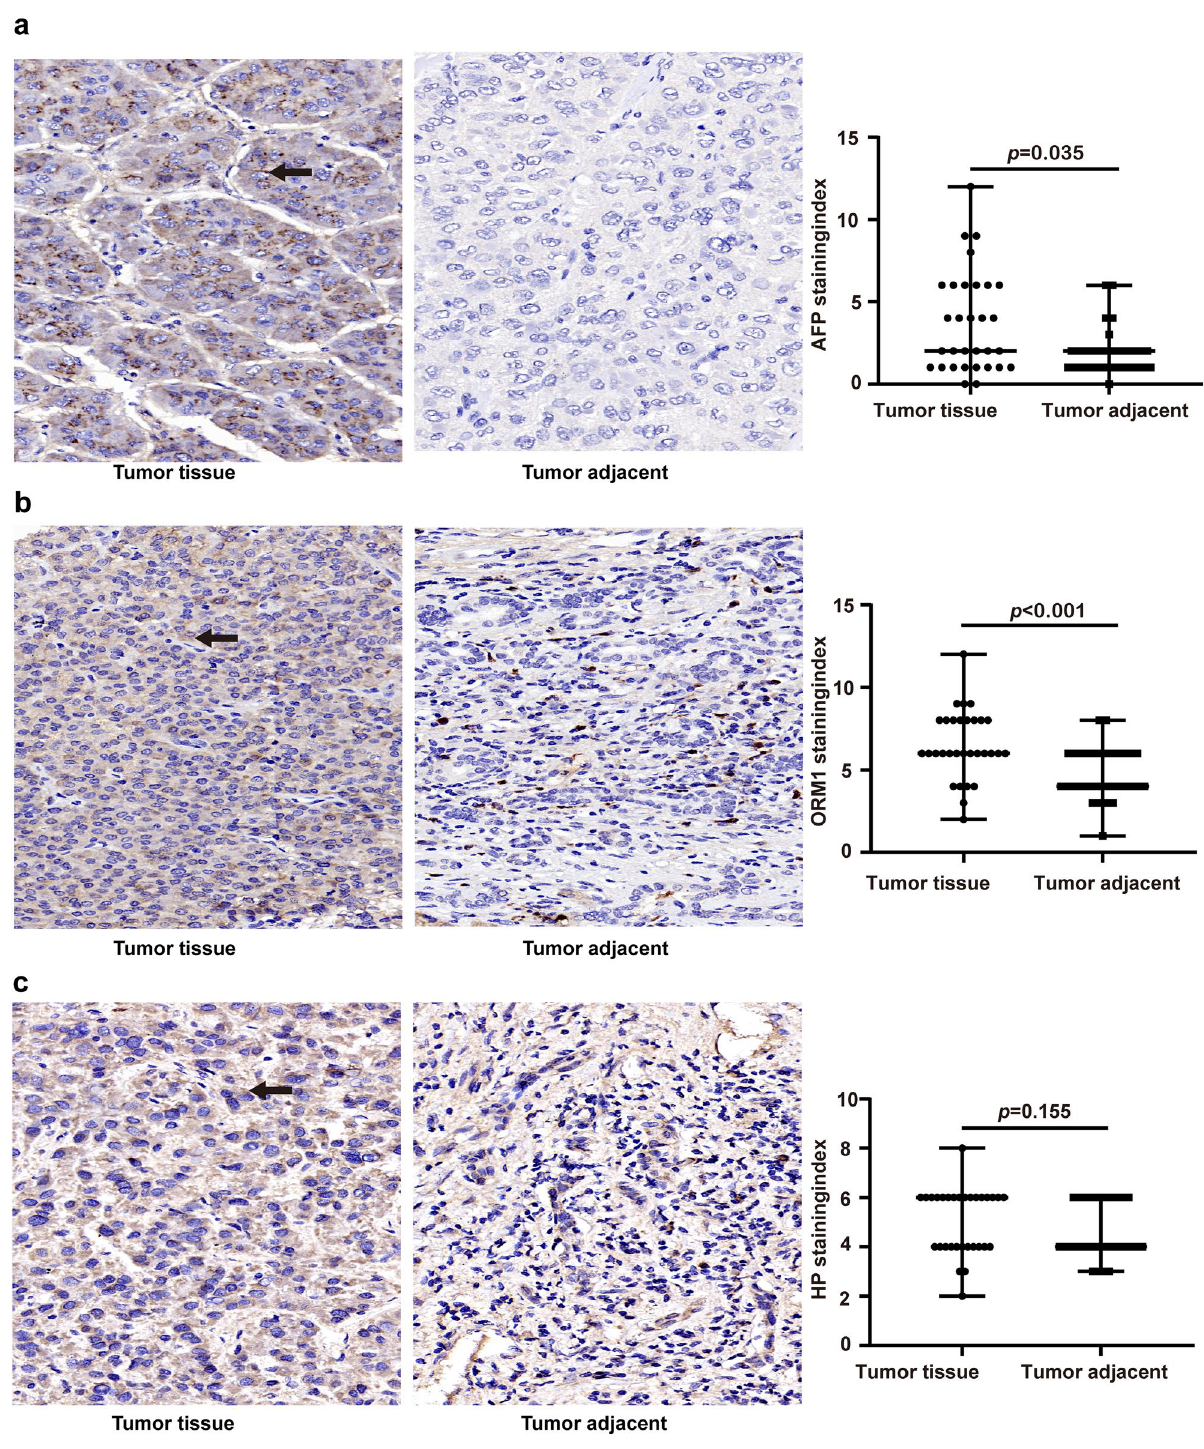
Figure 2. Immunohistochemistry verification. ( a ) Representative immunohistochemistry staining and analysis of differences in staining index of AFP in hepatocellular carcinoma tissue and tumor adjacent tissues. ( b ) Representative immunohistochemistry staining and analysis of differences in staining index of ORM1 in hepatocellular carcinoma tissue and tumor adjacent tissues. ( c ) Representative immunohistochemistry staining and analysis of differences in staining index of HP in hepatocellular carcinoma tissue and tumor adjacent tissues. AFP, ORM1 and HP are secreted proteins, localized in the cytoplasm and extracellular matrix. AFP α-fetoprotein, HP Haptoglobin, ORM1 Orosomucoid1. Data are shown as median with range, * p < 0.05, ** p <